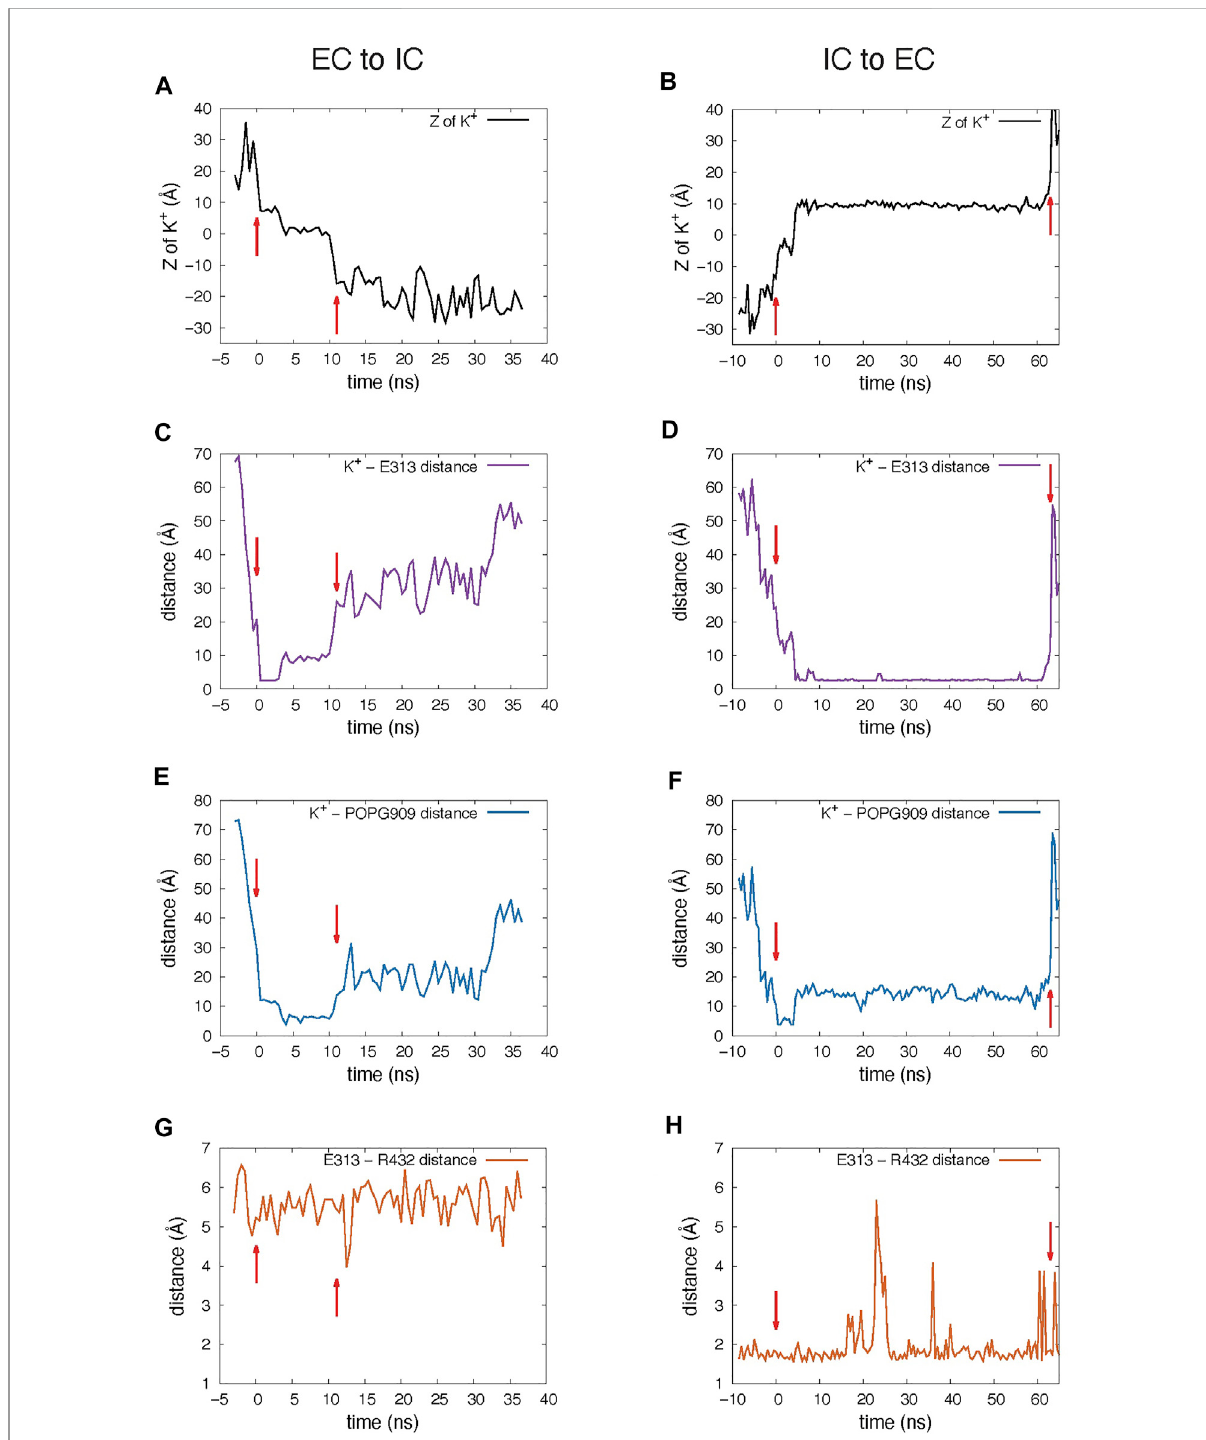
FIGURE 3 DynamicchangesduringtheK + iontranslocationeventsinthe10 μ sunbiasedMDsimulationofnhTMEM16.Inallpanels,redarrowsindicatethe beginning and end of the translocation process. (A,B) Changes in the Z position of the translocated K + ion during the EC-to-IC (A) and IC-to-EC (B) permeation events. The beginning of the EC-to-IC process (t = 0 was de fi ned by the time-point in the trajectory when the ion partitioned from the bulk into the groove (established interaction with E313), while the end of the IC-to-EC process was de fi ned by the time-point when the ion disengaged from E313 and diffused away to the EC milieu (See Supplementary Movies). Z = 0 Å represents the position of the C α atom of T381. (C,D) Distance between the translocated K + ion and E313. (E,F) Distance between the translocated K + ion and the closest headgroup P atom of the in-